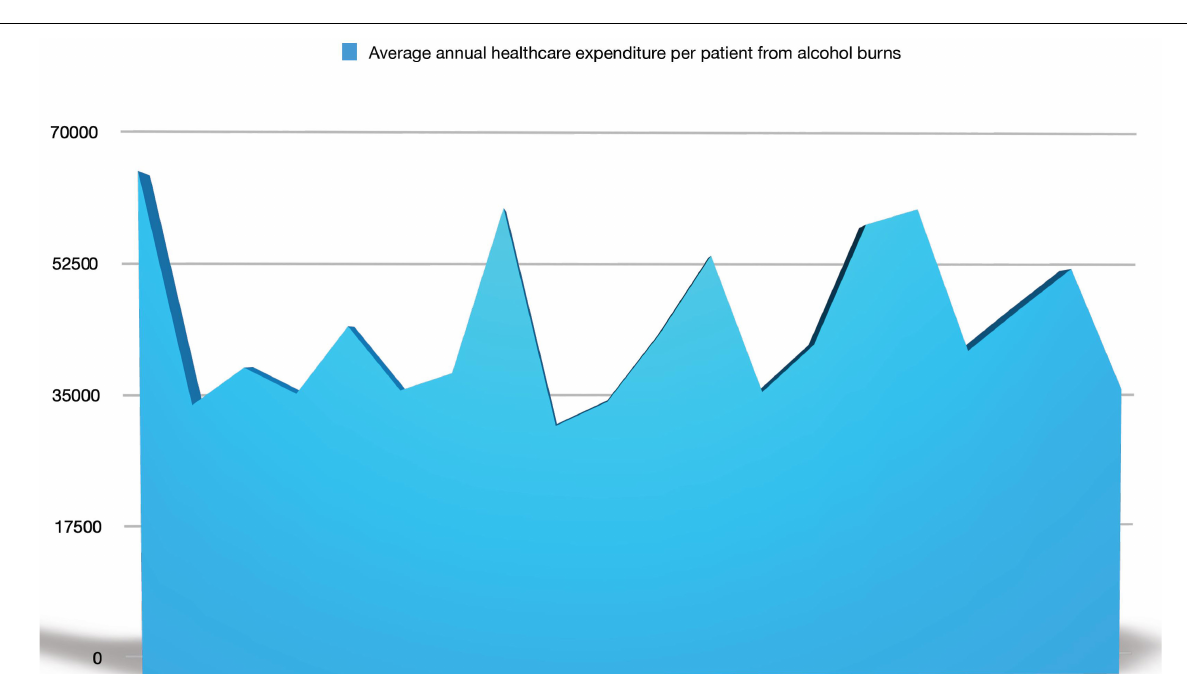
FIGURE 3 | Mean annual total costs per patient injured because of denatured